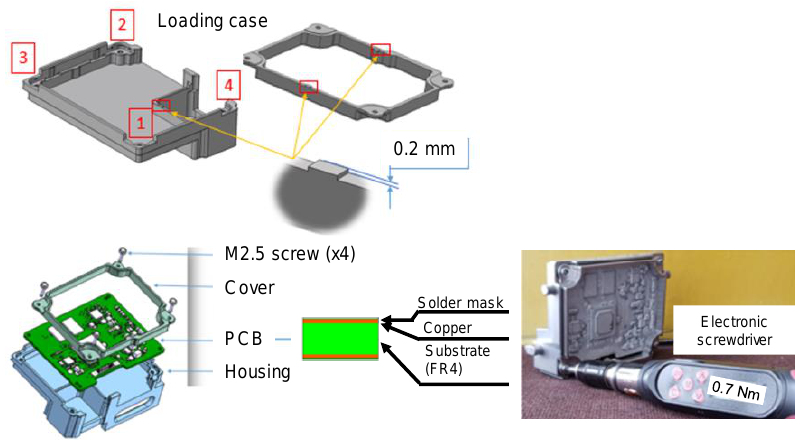
Figure 2. The PCB assembly between housing and cover. The electronic screwdriver for tightening the assembly.